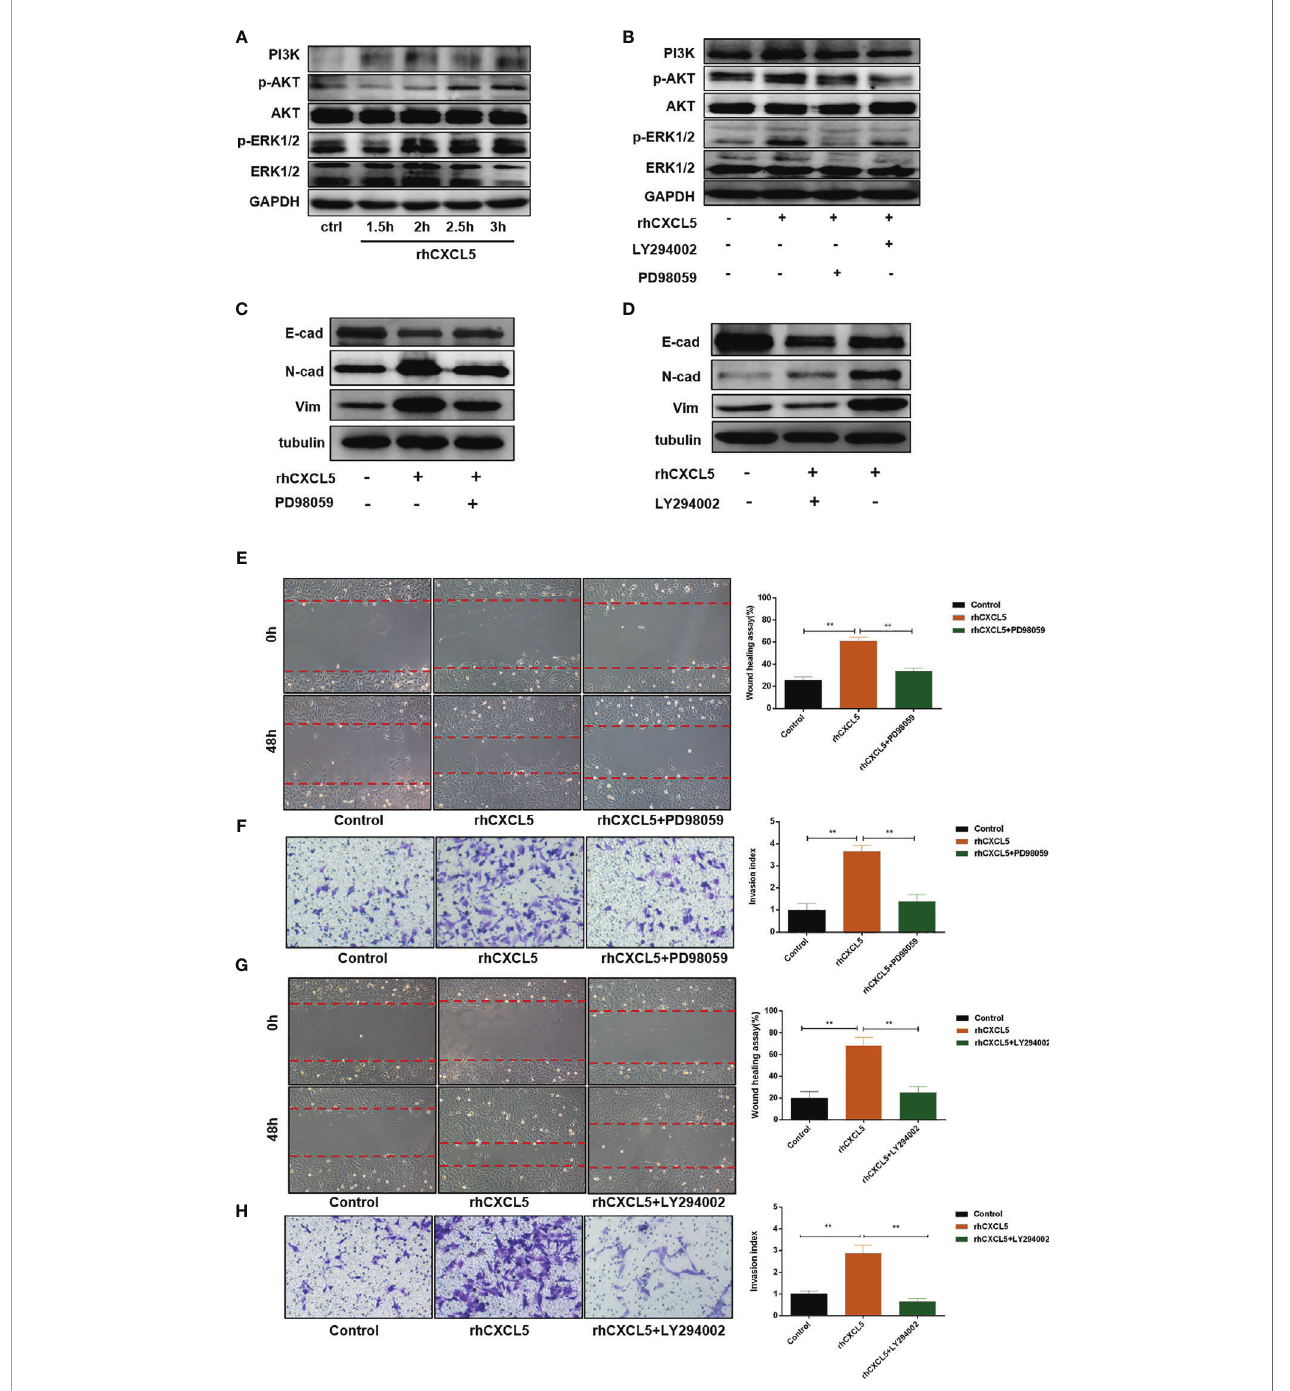
FIGURE 4 | CXCL5 activates PI3K/AKT/ERK1/2 signaling pathway to induce the EMT process of trophoblast cells. HTR-8 cells were pretreated with LY294002 (a PI3K/AKT inhibitor) or PD98059 (an ERK1/2 inhibitor) before treatment with rhCXCL5. (A) Western blotting analysis showed the activation of PI3K/AKT and ERK1/2 pathways in HTR-8 cells stimulated with rhCXCL5 for 1.5, 2, 2.5, and 3 h. (B) Western blotting analysis presented a notable blocking effect of LY294002 and PD98059 on p-AKT or p-ERK1/2, respectively. (C, D) Western blotting was performed to examine the expression of E-cadherin, N-cadherin, and vimentin in HTR-8 cells stimulated with PD98059 or LY294002 for 48 h. (E, F) Scratch wound healing and Matrigel invasion assays were performed to detect trophoblast migration and invasion abilities after stimulation with PD98059 for 48 h. (G, H) Scratch wound healing and Matrigel invasion assays were used to examine trophoblast migration and invasion abilities after stimulation with LY294002 for 48 h. Data are expressed as the mean ± SD. Column charts were used for quanti fi cations of the migration assay and invasion assays. Results are reported as fold change compared with the control group (** p < 0.01). CXCL5, C-X-C motif chemokine ligand